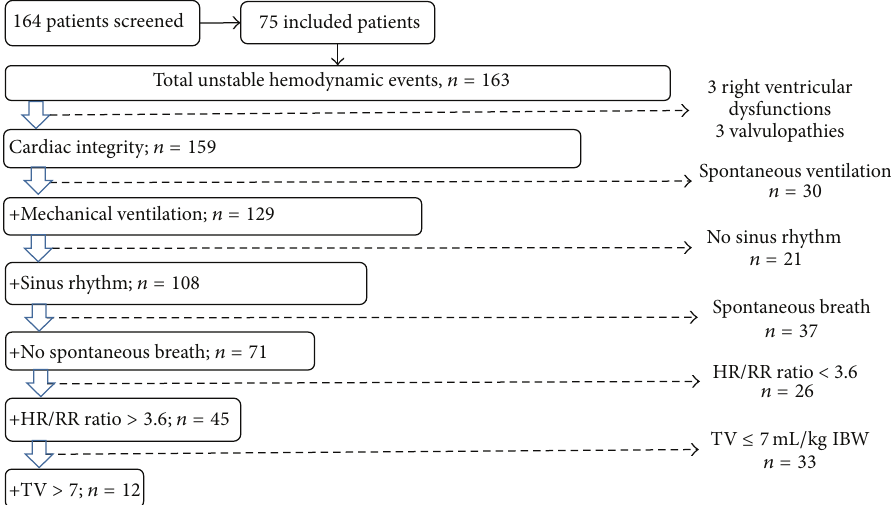
Figure 1: Flow chart showing pulse pressure variation applicability according to the accumulation of applicability criteria. This flow chart shows that one chosen criterion includes 159 UHE, two criteria include 129 UHE, three criteria include 108 UHE, four criteria include 71, five criteria include 45, and all criteria include 12 UHE. This figure systematically evaluates a large group of patients by exclusion criteria, and once a patient was excluded no further criteria were considered for that patient. We used this format to describe how a clinician might systematically approach the use of PPV in a patient. HR: heart rate; RR: respiratory rate; TV: tidal volume; UHE: unstable hemodynamic